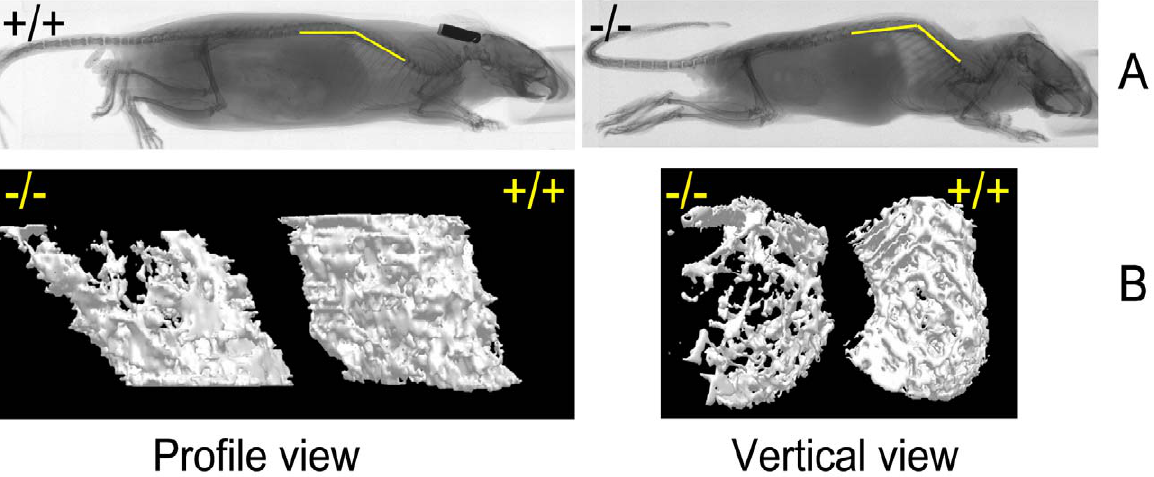
Figure 3. Skeletal abnormalities in the affected mice. (A) Radiographs of affected mouse and unaffected sibling at 26 weeks of age. Yellow bars indicate the position of spine. Scale bar=1 cm. (B) Micro–CT imaging of the femur trabecular bone in the wild-type and skcm 04Jus mice taken at 26 weeks of age. The 3D images of trabecular bone were reconstructed as described in Materials and Methods; scale bar=1 cm.